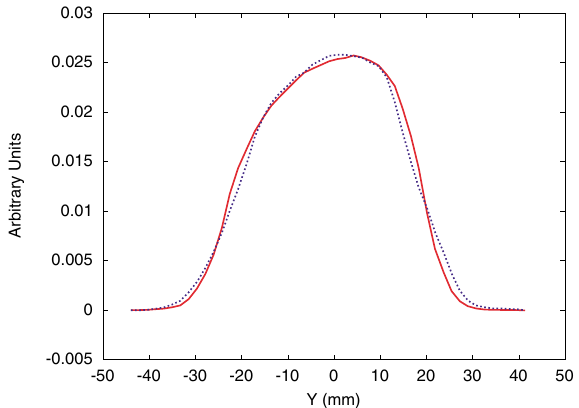
FIG. 23. (Color) Experimentally measured vertical beam pro- files for two different painting schemes of a high intensity beam at the end of accumulation. The (red) solid curve is the beam with a 17.51 mm injection offset, and the (blue) dashed curve is the beam with a 12.61 mm injection